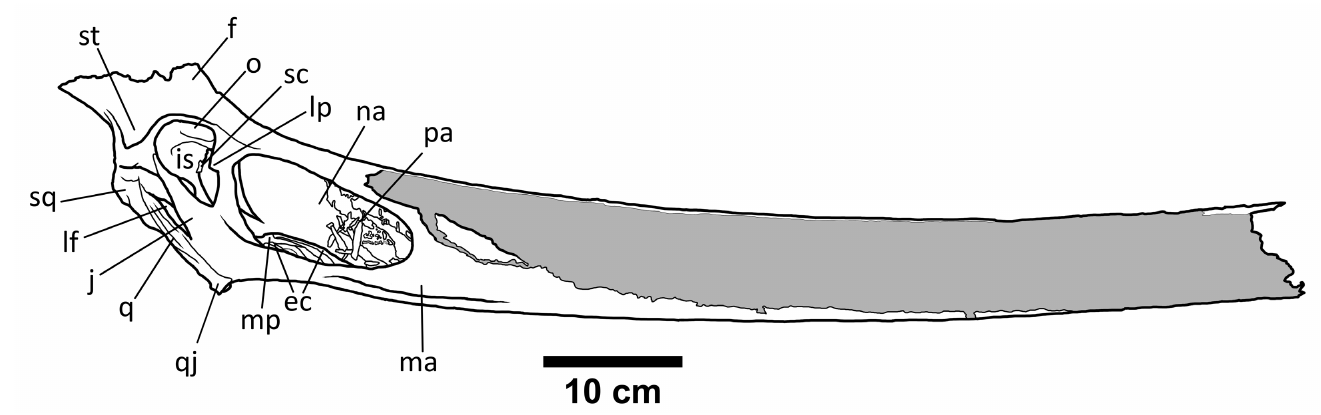
Figure 3. Outline diagram of the skull of UALVP 24238, not including impression of apical fragment. Gray shading indicates exposed endosteal strutting. Abbreviations: ec, ectopterygoids; f, frontal; is, interorbital septum; j, jugal; lp, lacrimal pro- cess; lf, lower temporal fenestra; ma, maxilla; mp, median processes of pterygoids; na, nasoantorbital fenestra; o, orbit; pa, palatine; q, quadrate; qj, quadratojugal; sc, segment of